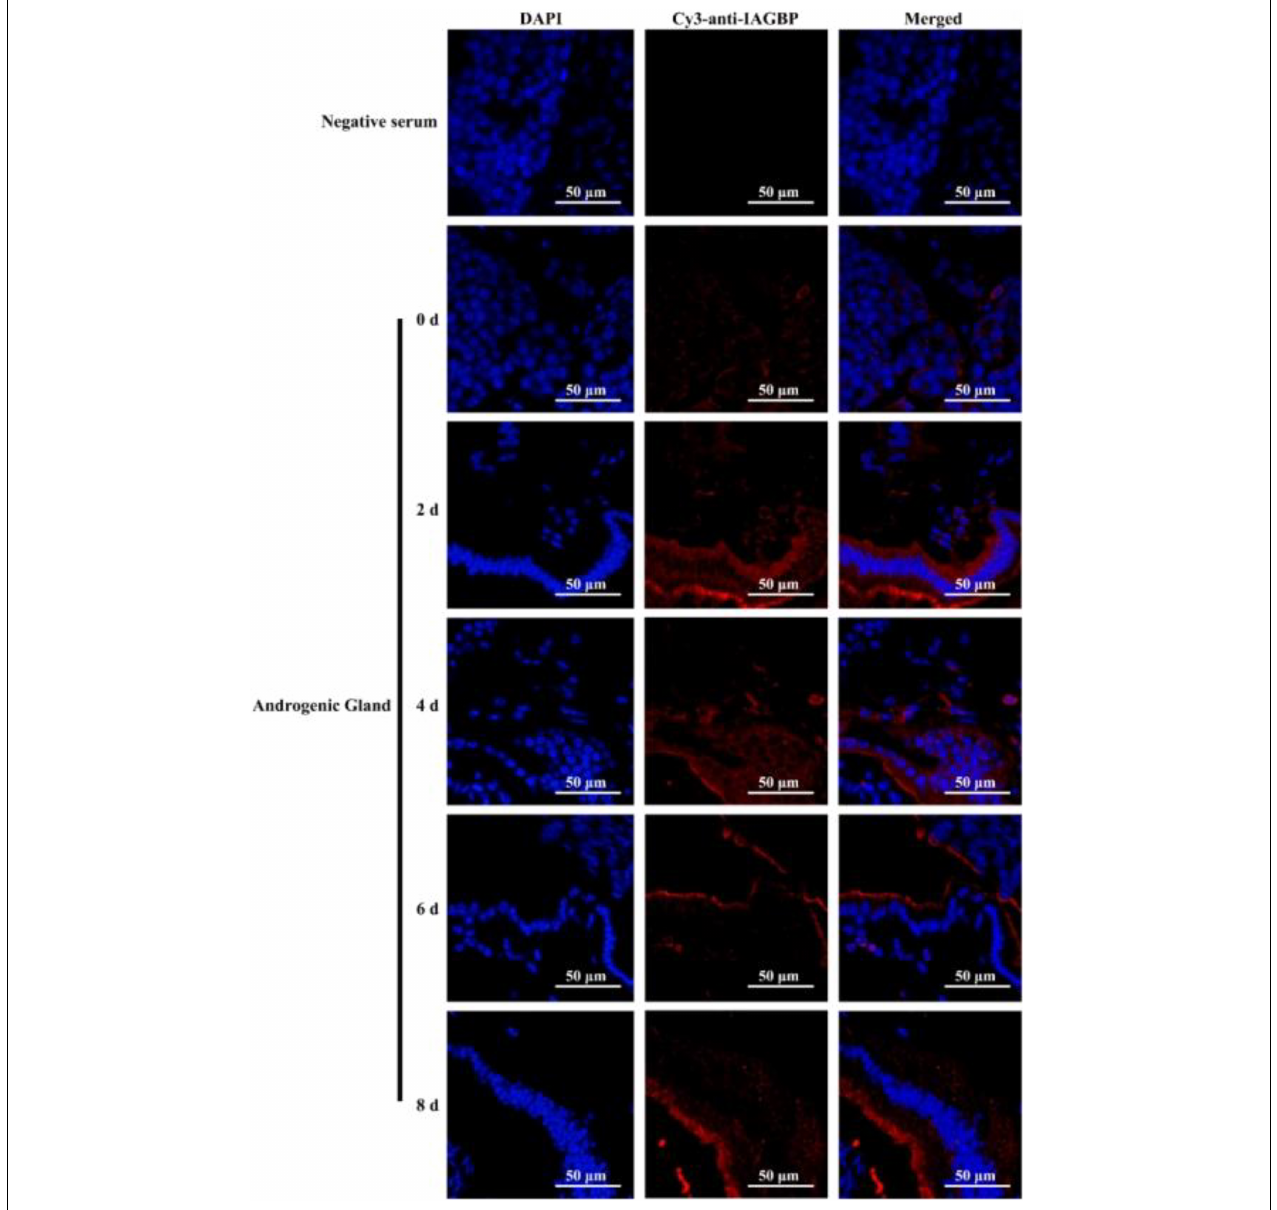
FIGURE 9 | The protein expression levels of Mr IAGBP on different days in androgenic gland after unilateral eyestalk ablation. Mr IAGBP was in red fluorescence signals. Negative serum served was as the control. Scale bar was indicated 50 µ